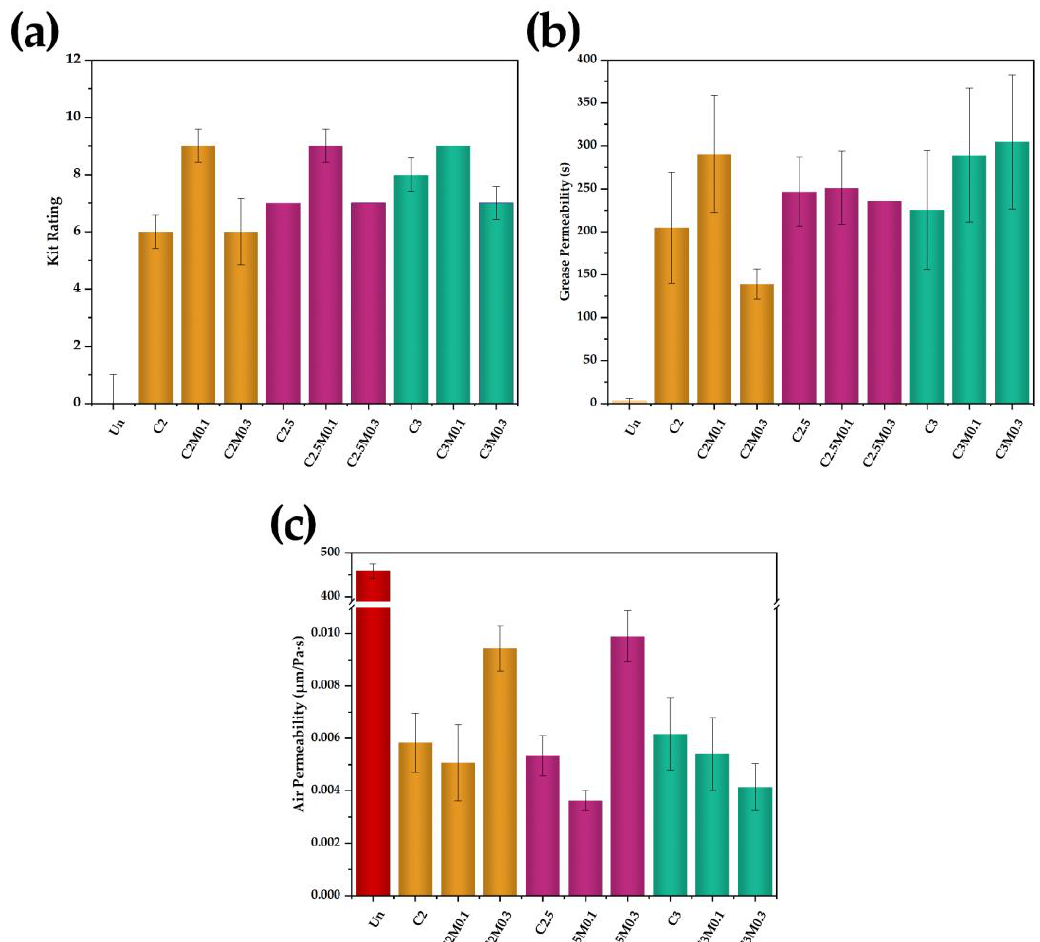
Figure 2. ( a ) Kit rating, ( b ) grease permeability, and ( c ) air permeability (μm/Pa·s) of the uncoated and coated